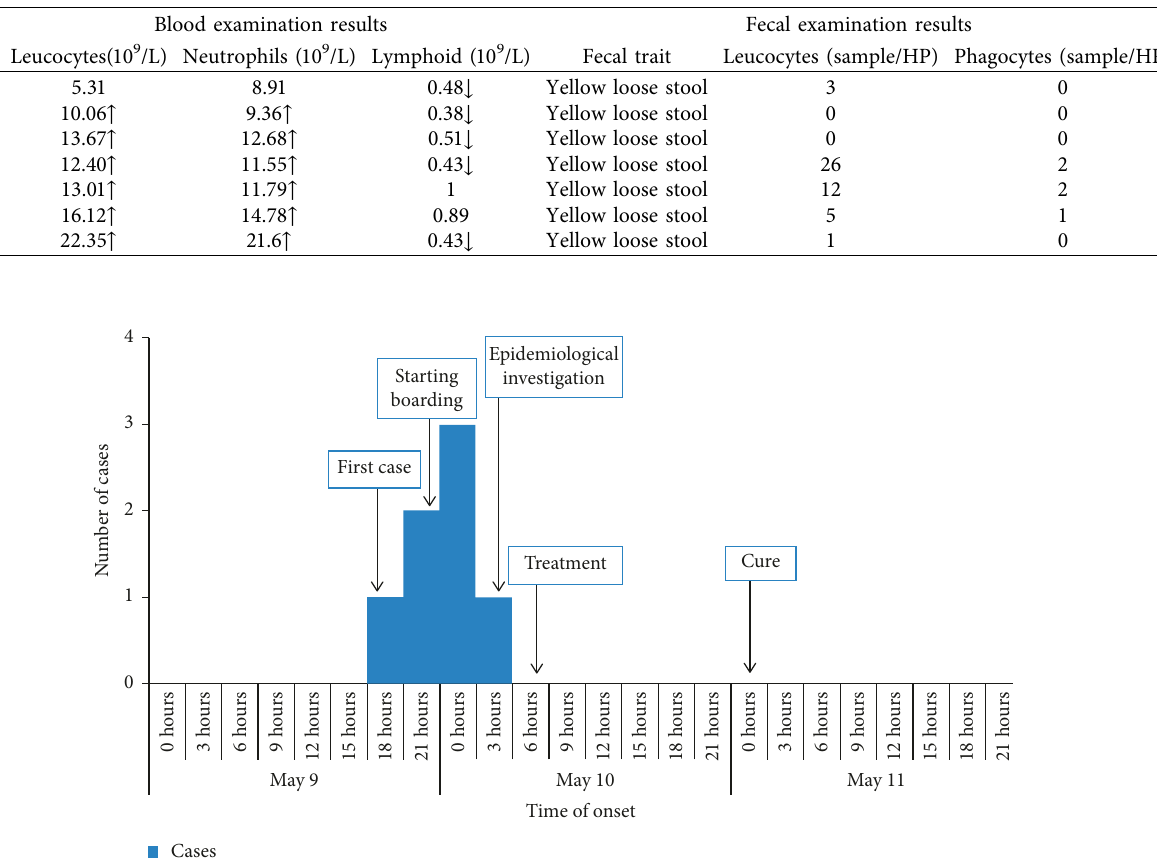
Table 2: The main clinical laboratory examination features of the